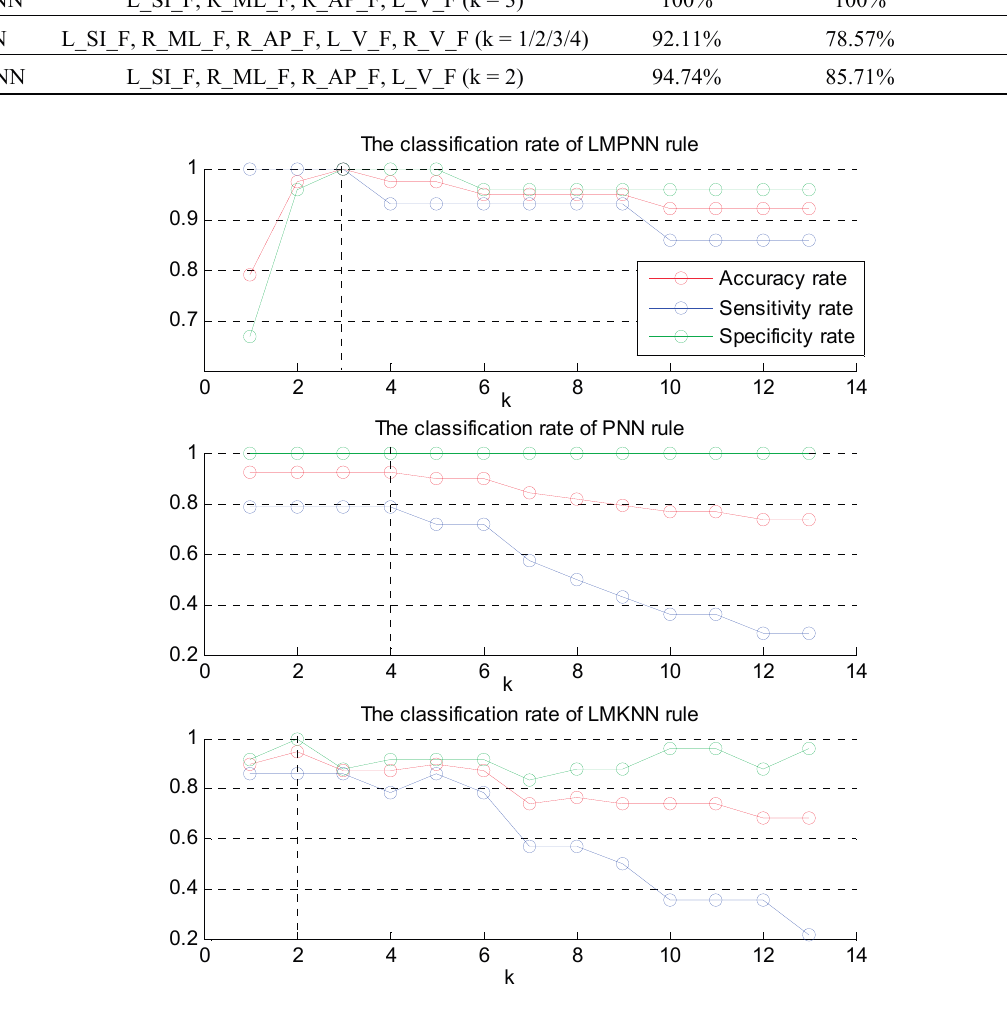
Figure 3. The classification rates of LMPNN, PNN, and LMKNN on real data via different k nearest neighbor